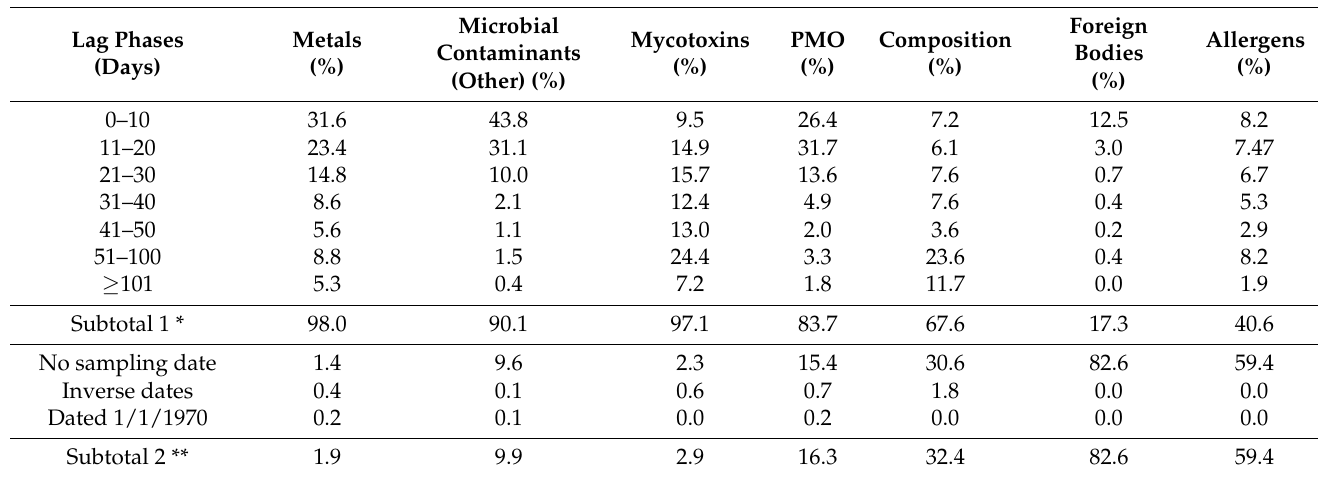
Table 3. Percent (%) share of lag phases in serious alert (sA) notifications of the seven food hazard categories (mycotoxins, microbial contaminants (other), foreign bodies, composition, allergens, metals, PMO) for all EU RASFF MS collectively, originating from the EU RASFF database